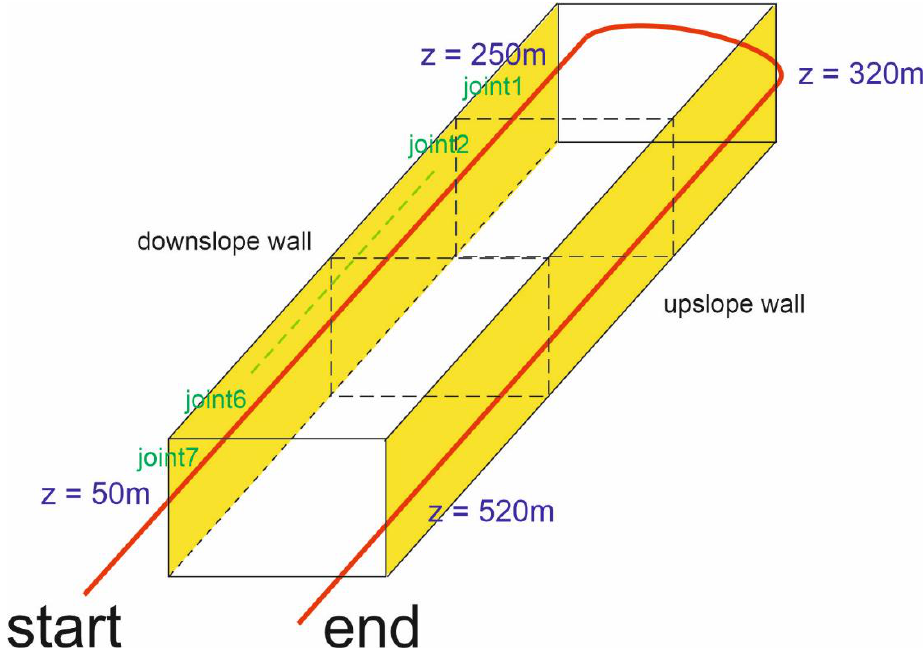
As the sensing element, a single-mode 0.9 mm tight-buffered optical fiber was hand-